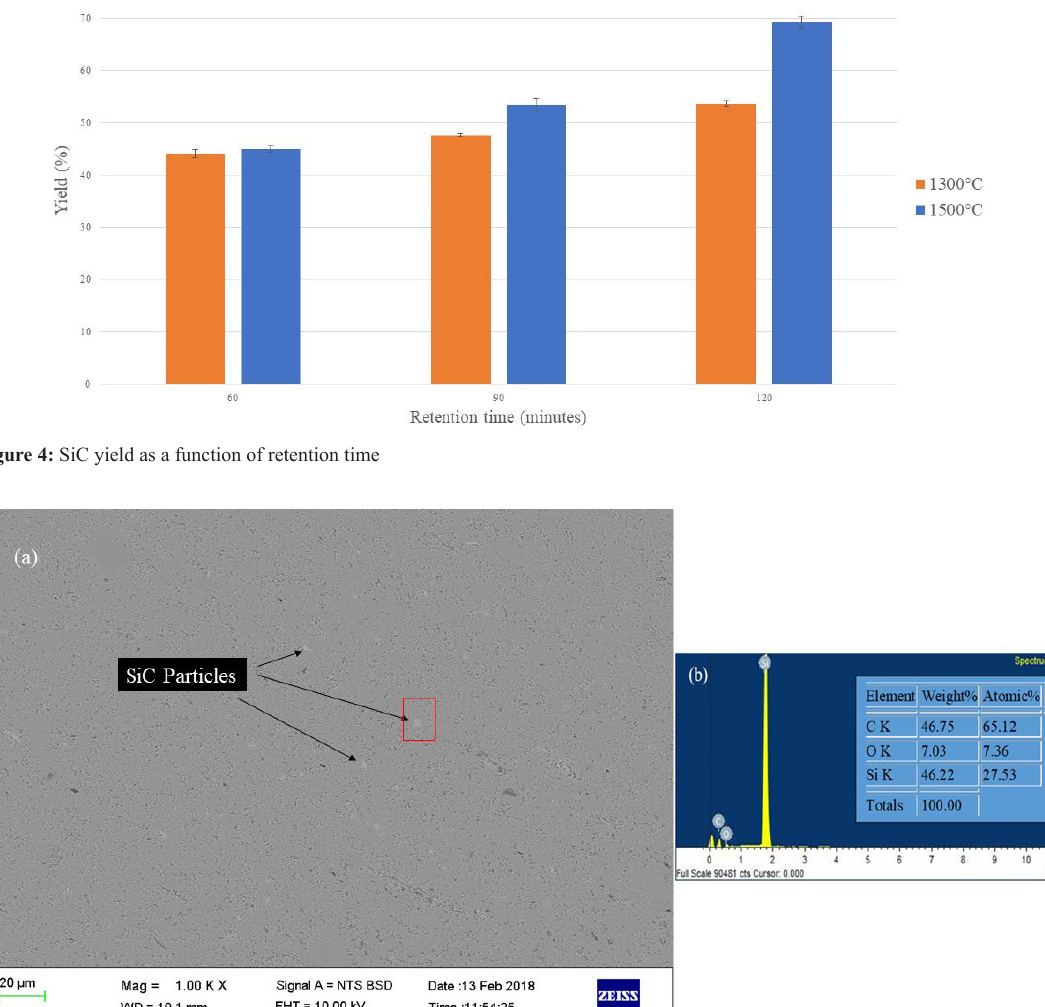
O -20 vol% SiC 2 3